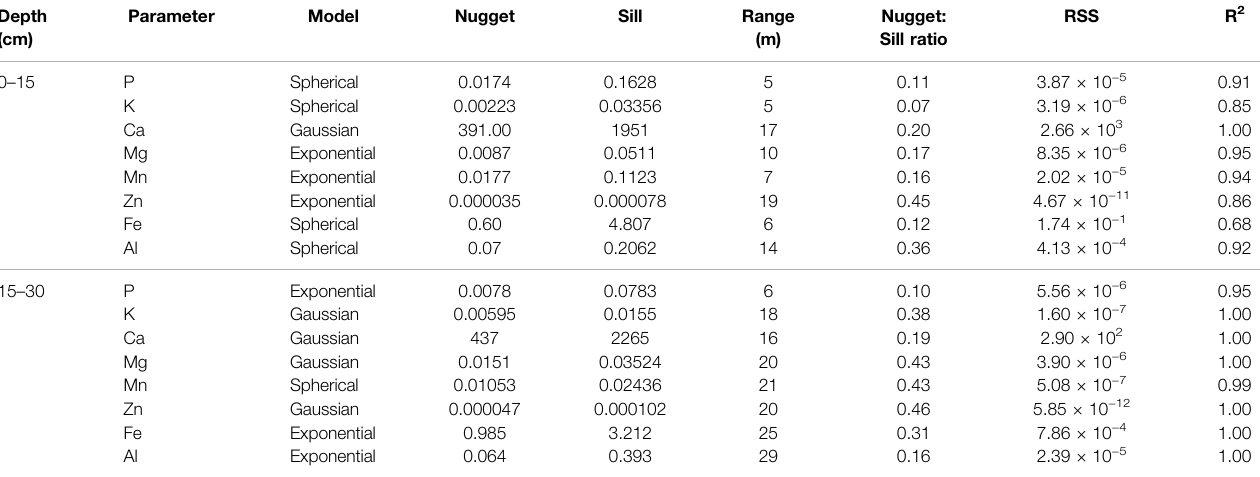
TABLE 6 | Spatial dependence of total concentrations of selected elements in the surface and subsurface horizons of the rewetted peatland. Depth Parameter (cm)